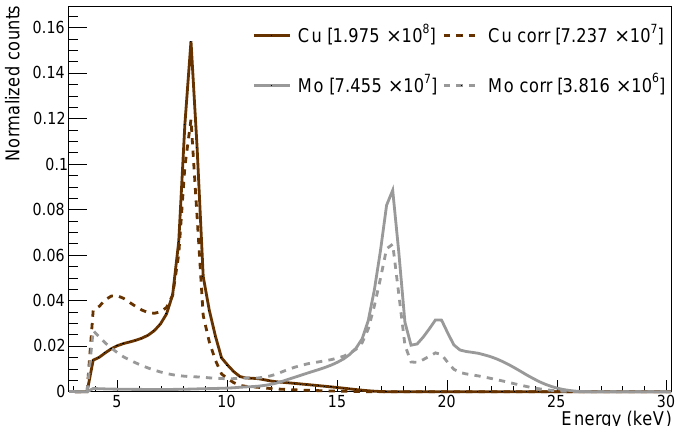
Figure 18. Copper and molybdenum X-ray fluorescence spectra measured with the HEXITEC detector (solid) and corrected for the energy dependent photon absorption probabilities in 25 µ m silicon (dashed). All spectra are normalized by the corresponding constants stated in the